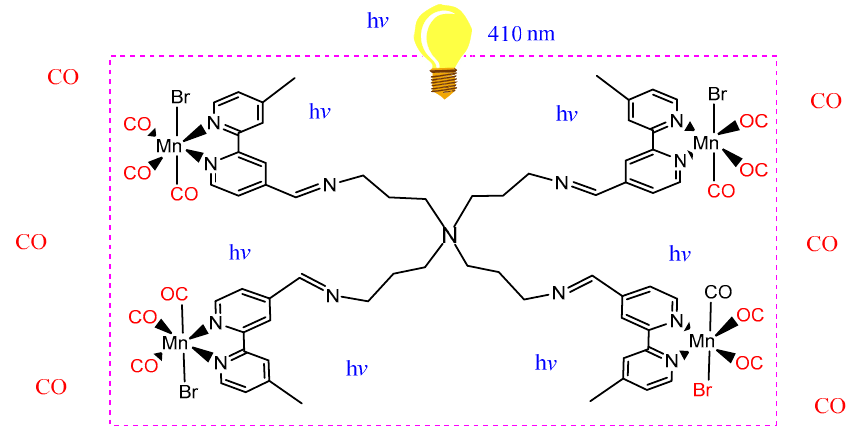
Figure 26. Metallodendrimers photoactivated CORMats.